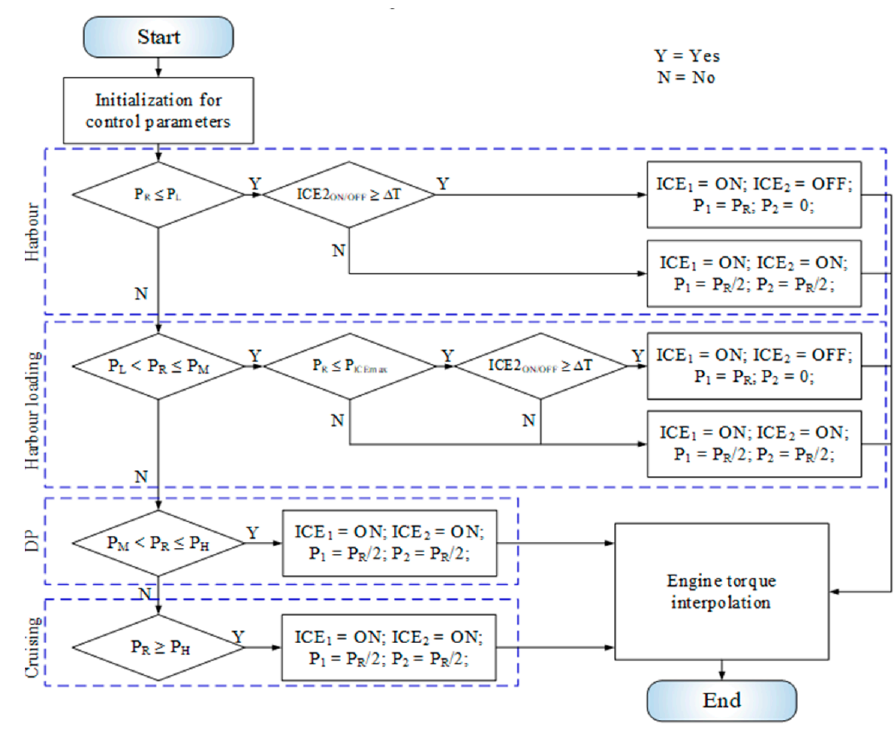
Figure 8. Conventional DGC control block